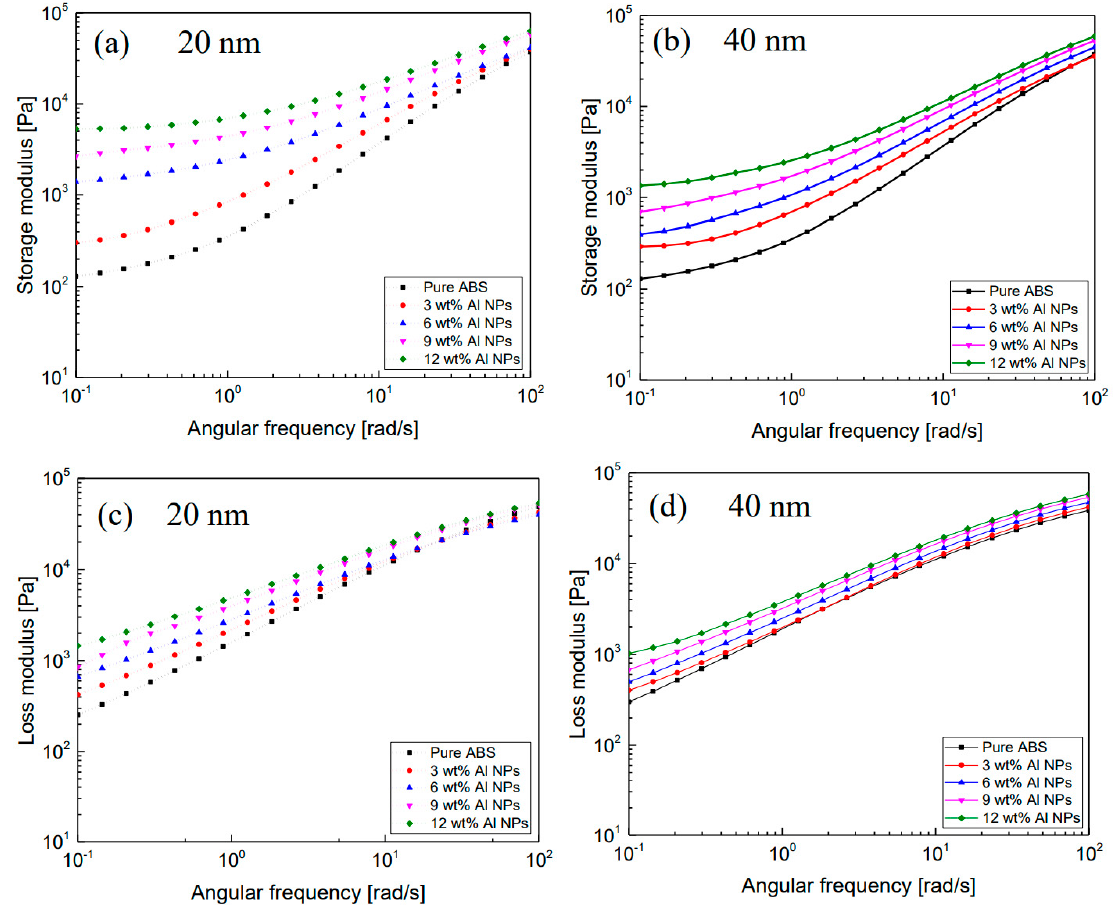
Figure 5. Storage modulus (G ′ ) and loss modulus (G ″ ) curves of ABS/Al 20 nm and 40 nm nanoparticle composites. ( a , c ) are ABS/Al 20 nm, ( b , d ) are the storage modulus and loss modulus curves of the 40 nm nanoparticle composite.